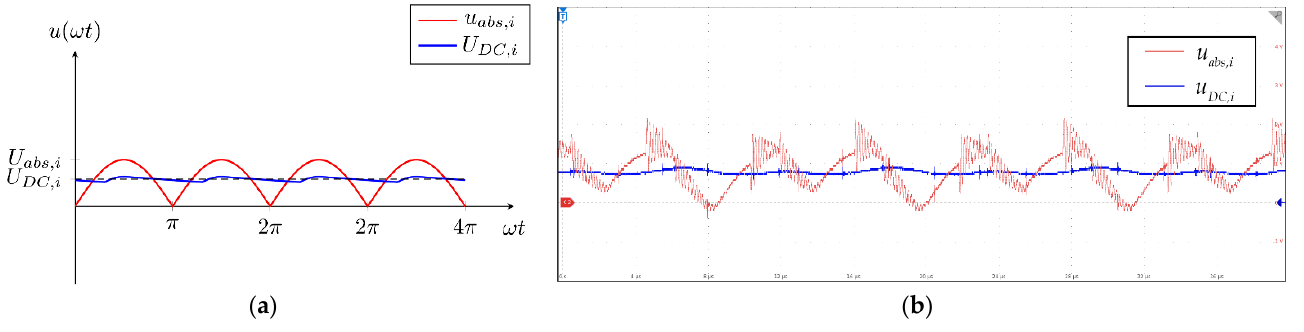
Figure 10. Input and output voltages of the third stage of the measurement circuit. ( a ) theoretical waveforms; ( b ) waveforms measured on the measurement system.